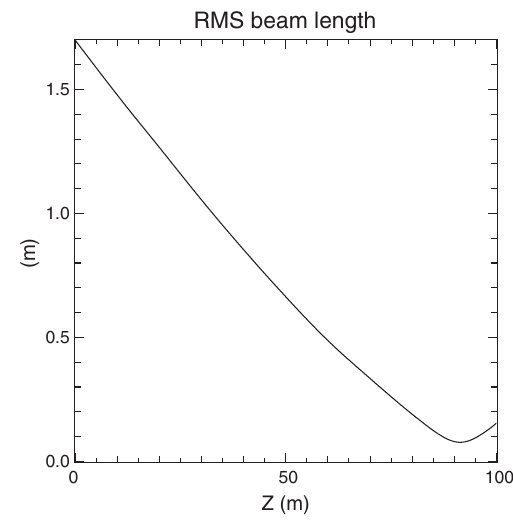
FIG. 2. Beam length as a function of z